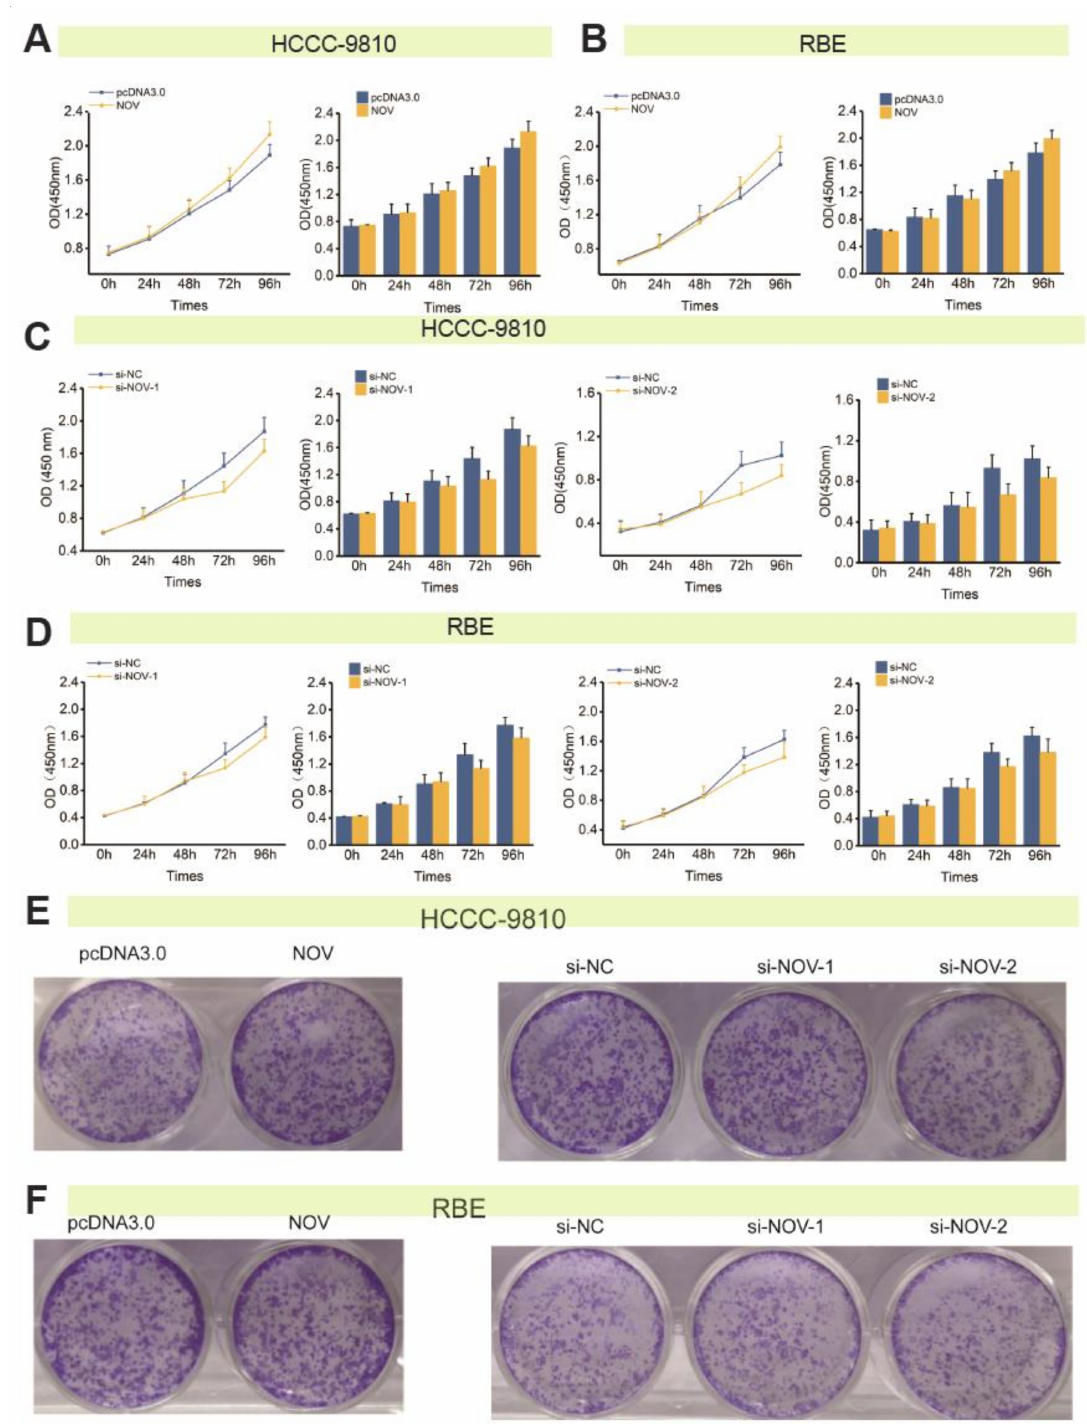
Figure 4. NOV regulates the proliferation of ICC cells. ( A ) The effect of NOV overexpression on cell proliferation via CCK-8 method in HCCC-9810. ( B ). The effect of NOV overexpression on cell proliferation via the CCK-8 method in RBE. ( C ) The effect of NOV silencing on cell proliferation via CCK-8 method in HCCC-9810. ( D ) The effect of NOV silencing on cell proliferation via the CCK-8 method in RBE. ( E ) The effect of NOV overexpression and silencing on cell proliferation via colony-forming assay in HCCC-9810. ( F ) The effect of NOV overexpression and silencing on cell proliferation via colony-forming assay in